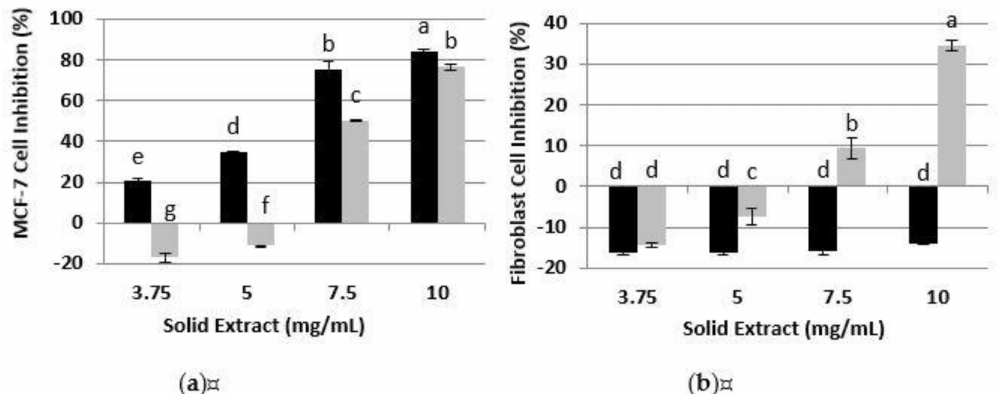
Figure 5. Cell inhibition of protein hydrolysates extracted from RPI with different commercial proteases: DH1 with Alkalase 2.4 L ( (cid:4) ), DH1 with Thermoase PC10F ( (cid:4) ). ( a ) On the MCF-7 cancer cell line; ( b ) on healthy human fibroblast cells. Percentages of inhibition are calculated with reference to the signal of cells grown with extract-free cell culture media. Mean ± SD ( n = 3). The same letter means no significant difference ( p < 0.05), 95% confidence